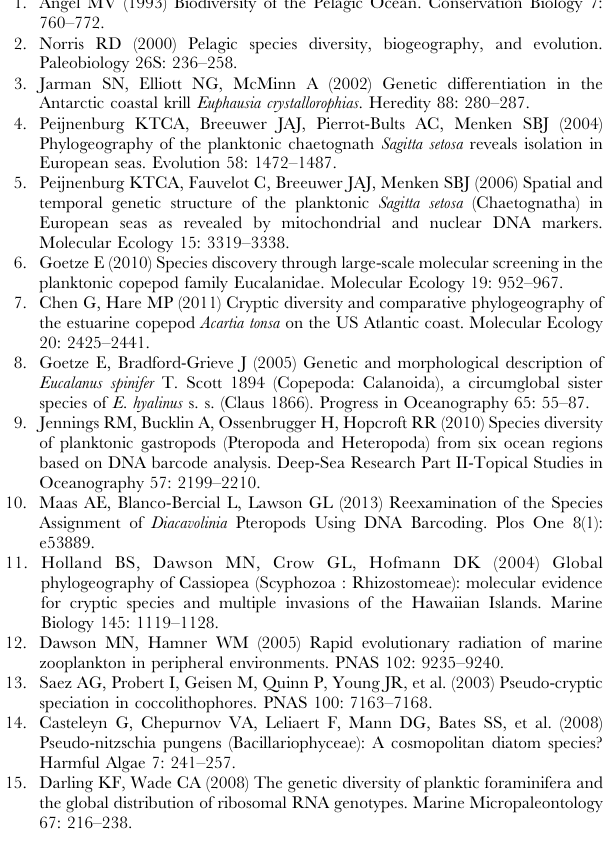
text indicates haplotypes that were sampled more than once. The scale bar units are in substitutions per site. (TIF) Table S1 Population structure within clade A, across the Indian, North Pacific, and North Atlantic Oceans. Results from a hierarchical analysis of molecular variance (AMOVA). Table S2 Pairwise h ST values between sampling sites within clade A. Significant values ( P -value , 0.05) are shown in bold . The Q-value was , 0.05 for all P -values , 0.05. Indian